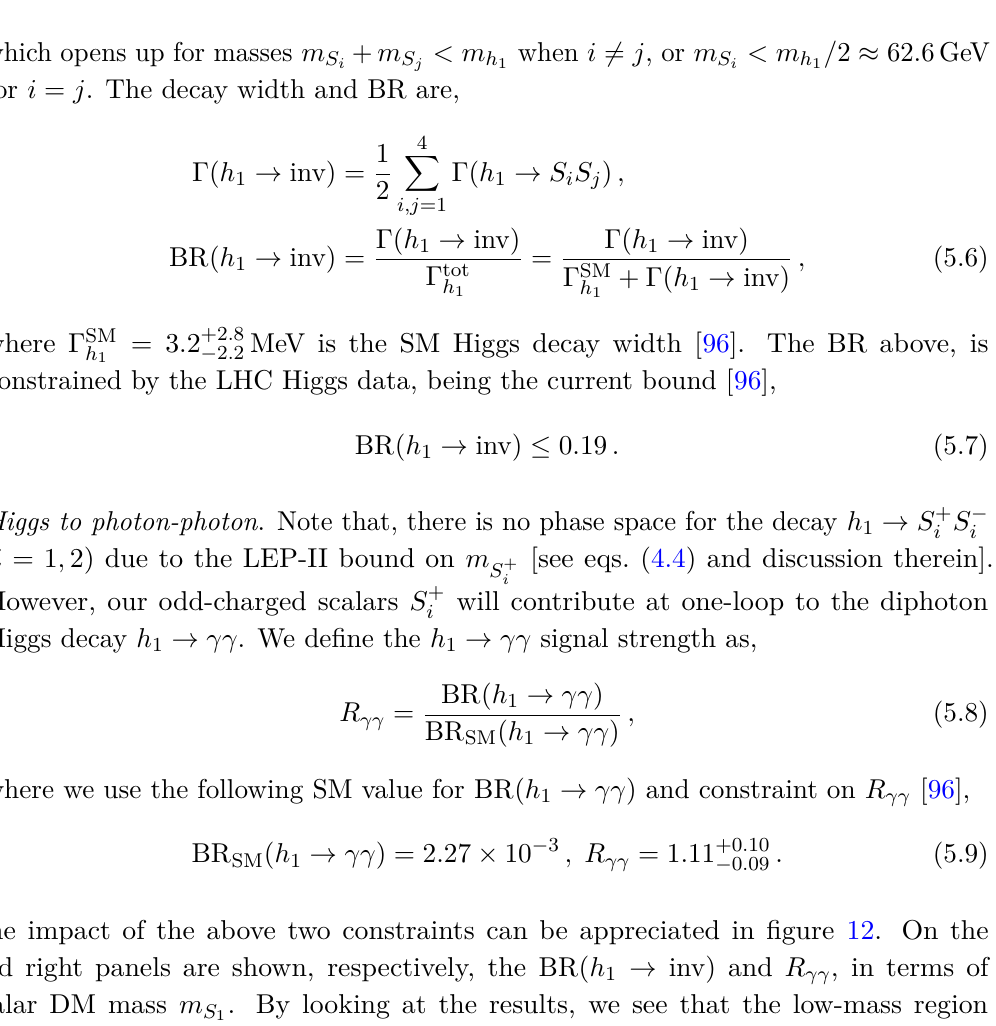
Figure 12 . On the left [right], the BR( h 1 → inv ) [ R γγ ] in terms of the scalar DM mass m S the blue-shaded region[s] being excluded by the constraint in eq. (5.7) [eq. (5.9)] (see text for details). To distinguish points, in terms of relic density, we use the colour code employed in figure